Question: What caption would you write for this figure?
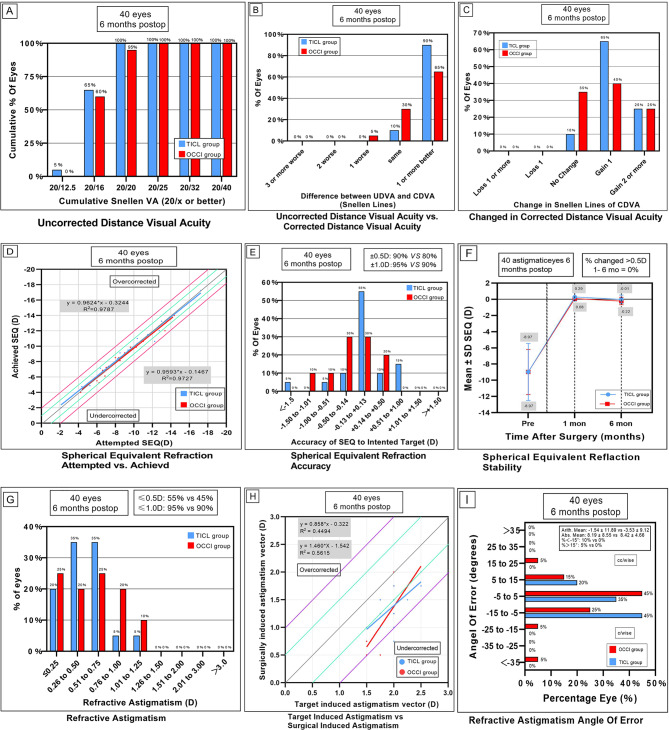
Answer: Visual and refractive outcomes after TICL implantation and ICL combined with OCCI. ( A ) Postoperative uncorrected distance visual acuity (UDVA) distribution (≥20/20). ( B ) Proportion of eyes with postoperative UDVA improved by one line or more compared with preoperative corrected distance visual acuity (CDVA). ( C ) Change in CDVA from preoperative to 6 months postoperatively. ( D ) Linear regression analysis of attempted versus achieved spherical equivalent (SEQ). ( E ) Refractive accuracy: percentage of eyes with SEQ within ±0.50 D and ±1.00 D. ( F ) Stability of SEQ at 1 and 6 months postoperatively. ( G ) Residual refractive astigmatism within 0.50 D and 1.00 D. ( H ) Linear regression of target‑induced astigmatism (TIA) versus surgically induced astigmatism (SIA). ( I ) Distribution of angle of error (AE) at 6 months. D = diopters; logMAR = logarithm of the minimum angle of resolution